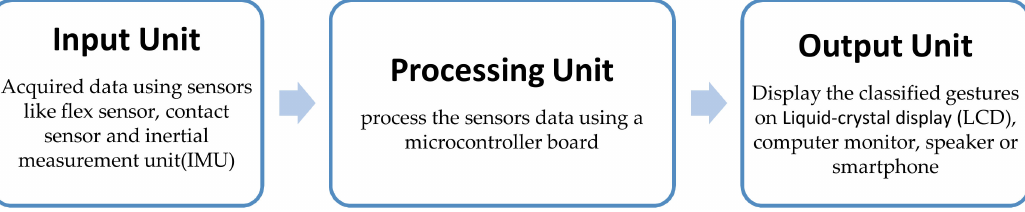
Figure 5. The main hardware components of the glove-based